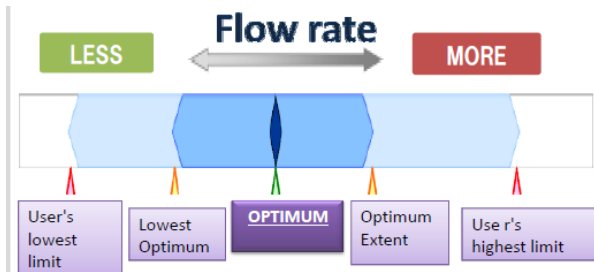
Figure 6. Graph of flow rate evaluation for